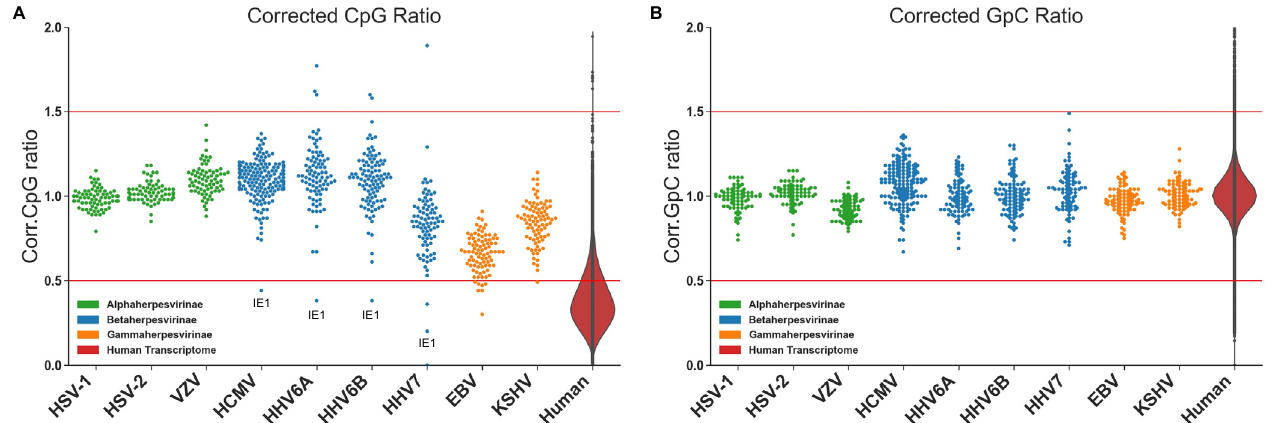
Figure 2. Specific suppression of CpG nucleotides within the immediate early genes of beta-herpesviruses. ( A ) The CpG content of annotated open reading frames from human herpesvirus genomes are shown, following normalisation for length and GC content. A corrected CpG ratio of one reflects the expected number of CpGs based on GC content of a transcript. ( B ) Equivalent data for GpC dinucleotide ratios are shown as a control demonstrating the CpG dinucleotide pattern is specific. No clear trend is seen with TpA (data not shown). Red lines indicate arbitrary two-fold decrease or 1.5 fold increase in dinucleotide frequency for visual comparison. Dinucleotide content of the human transcriptome is shown as a violin plot for comparison.